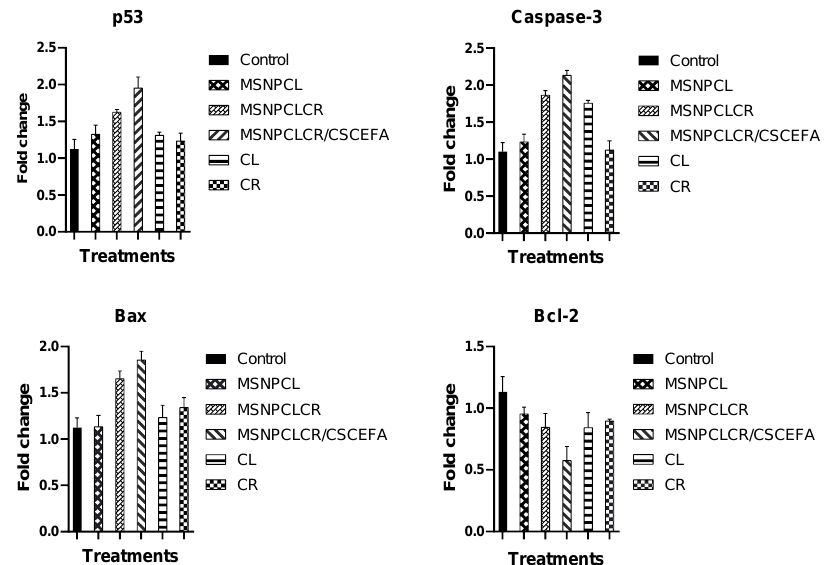
Figure 7. RT – PCR values for p53, caspase-3, Bax, and Bcl-2 markers of apoptosis for nanoformulations compared with free CL and CR against MCF-7 cancer cells treated at the IC50 concentration (µg/mL) of each formulation by incubation for 72 h. Data are presented as mean ± SD. The concentration was prepared for nanoformulations as an equivalent concentration of CL and CR in the nanoformulation equal to free CL and CR.